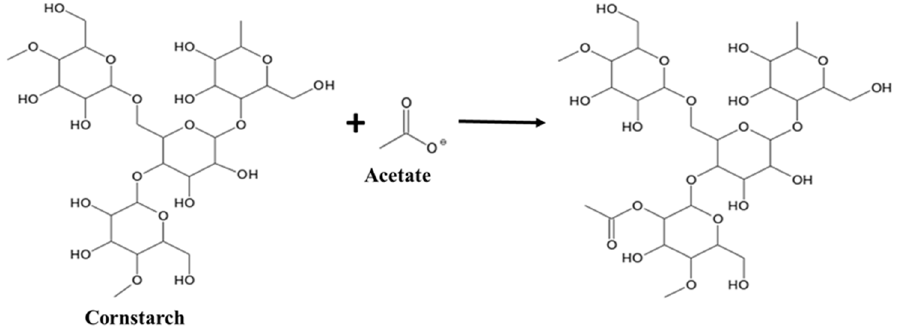
Figure 2. Acetylation mechanism of cornstarch reaction with metal acetates.